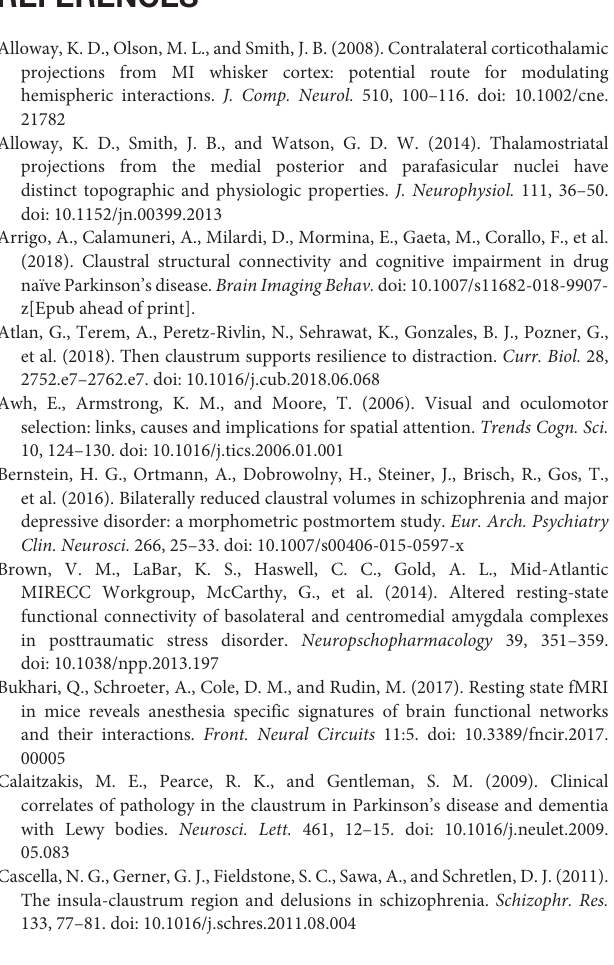
FIGURE S3 | Interhemispheric cortico-thalamo-cortical loop between mPFC and Cg via MD thalamus. (A) Thalamic labeling from the anterograde and retrograde injections in PrL cortex shown in Figures 5A–C . Note the anterogradely labeled terminals in the right hemisphere MD thalamus (contralateral to the FR injection site), which are intermingled with retrograde neurons from the FG injection in the right hemisphere PrL. (B–E) Thalamic labeling from the BDA injection into Cg cortex shown in Figure 5I . Note the terminal labeling in the contralateral MD. Data modified with permission from Smith and Alloway (2014) and Smith et al. (2017). Scale bars: 500 µ m in left image of panel (A) ; 50 µ m in right image of panel (A) ; 250 µ m in (B,D) ; 100 µ m in (C) . Abbreviations: 3V, third ventricle; AM, anteromedial thalamic nucleus; AV, anteroventral thalamic nucleus; VL, ventral lateral nucleus; VM, ventral medial nucleus; MD, mediodorsal nucleus; Re, reuniens; IAM, interanteromedial nucleus; ac, anterior commissure; CM, centromedial thalamic nucleus; cc, corpus callosum; ec, external capsule; ns, neostriatum; Rt, thalamic reticular nucleus; sm, stria medularis; f, fornix; vCLA, ventral claustrum.